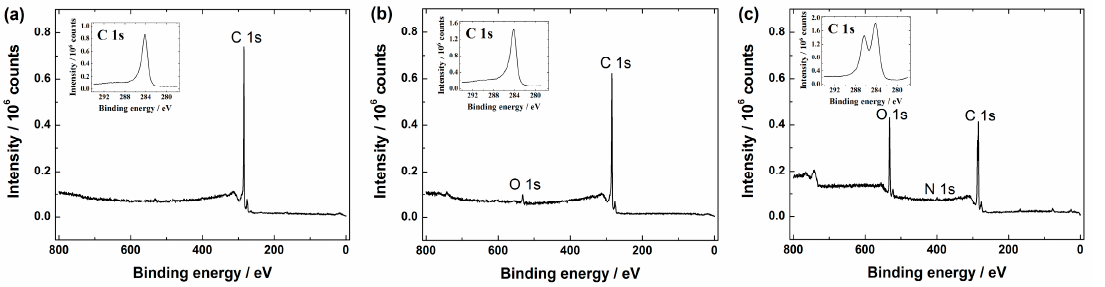
Figure 3. XPS (X ‐ ray photoelectron spectroscopy) survey spectra of: ( a ) graphene nanopowder (from Graphene Supermarket); ( b ) graphene nanoplatelet aggregates (from Strem Chemicals); and ( c ) reduced graphene oxide. The insets show the high resolution XPS spectra in the C 1s region.